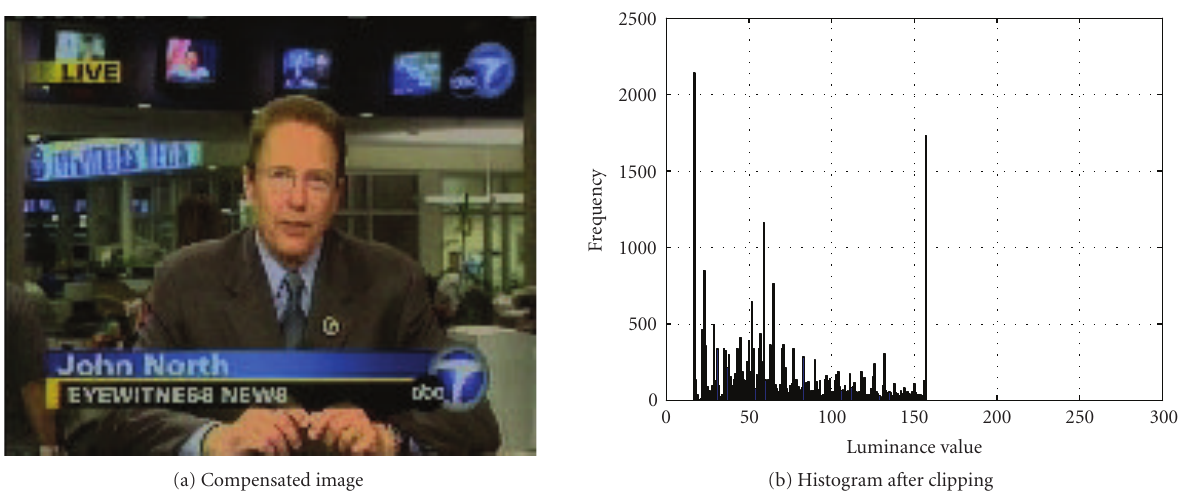
Figure 4: Image and its luminance histogram after